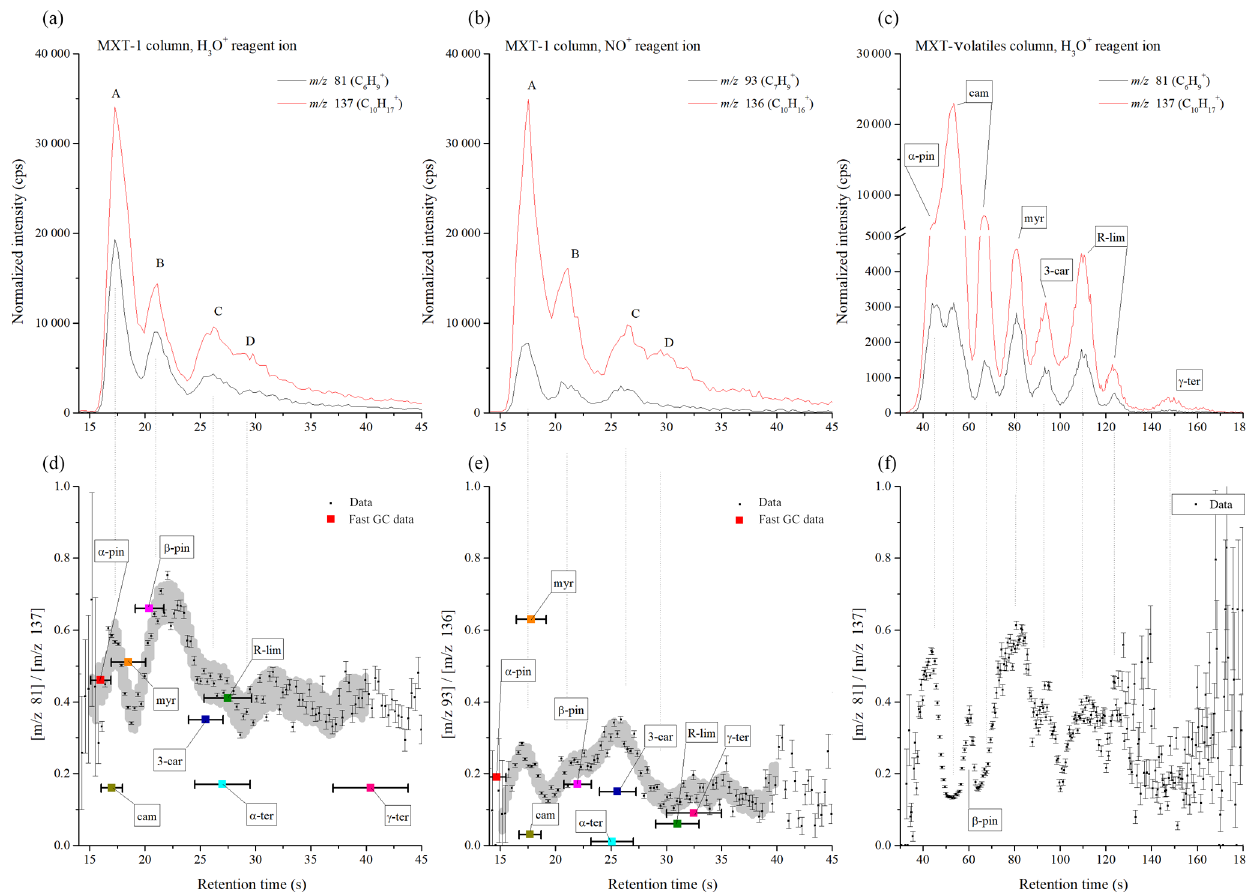
Figure 4. Chromatograms of the mixture of monoterpenes (top row) measured by H 3 O + (a) and NO + (b) reagent ions, obtained using the MXT-1 column. A, B, C, and D represent characteristic peaks in the chromatogram. For each chromatogram, the product ion signal ratio r i is presented in the lower figures. The grey data background represents the calculated standard deviation of the data by Savitzky–Golay smoothing between 15 and 40s. The position and value of the ratio for individual monoterpenes is based on the fast GC MXT-1 measurements presented in Table 1. Note that the retention times are determined by the fast GC conditions and do not depend on which SIFT-MS reagent ion is used. The signal intensities are the analyte ion count rates normalized to a reagent ion count rate of 10 6 s − 1